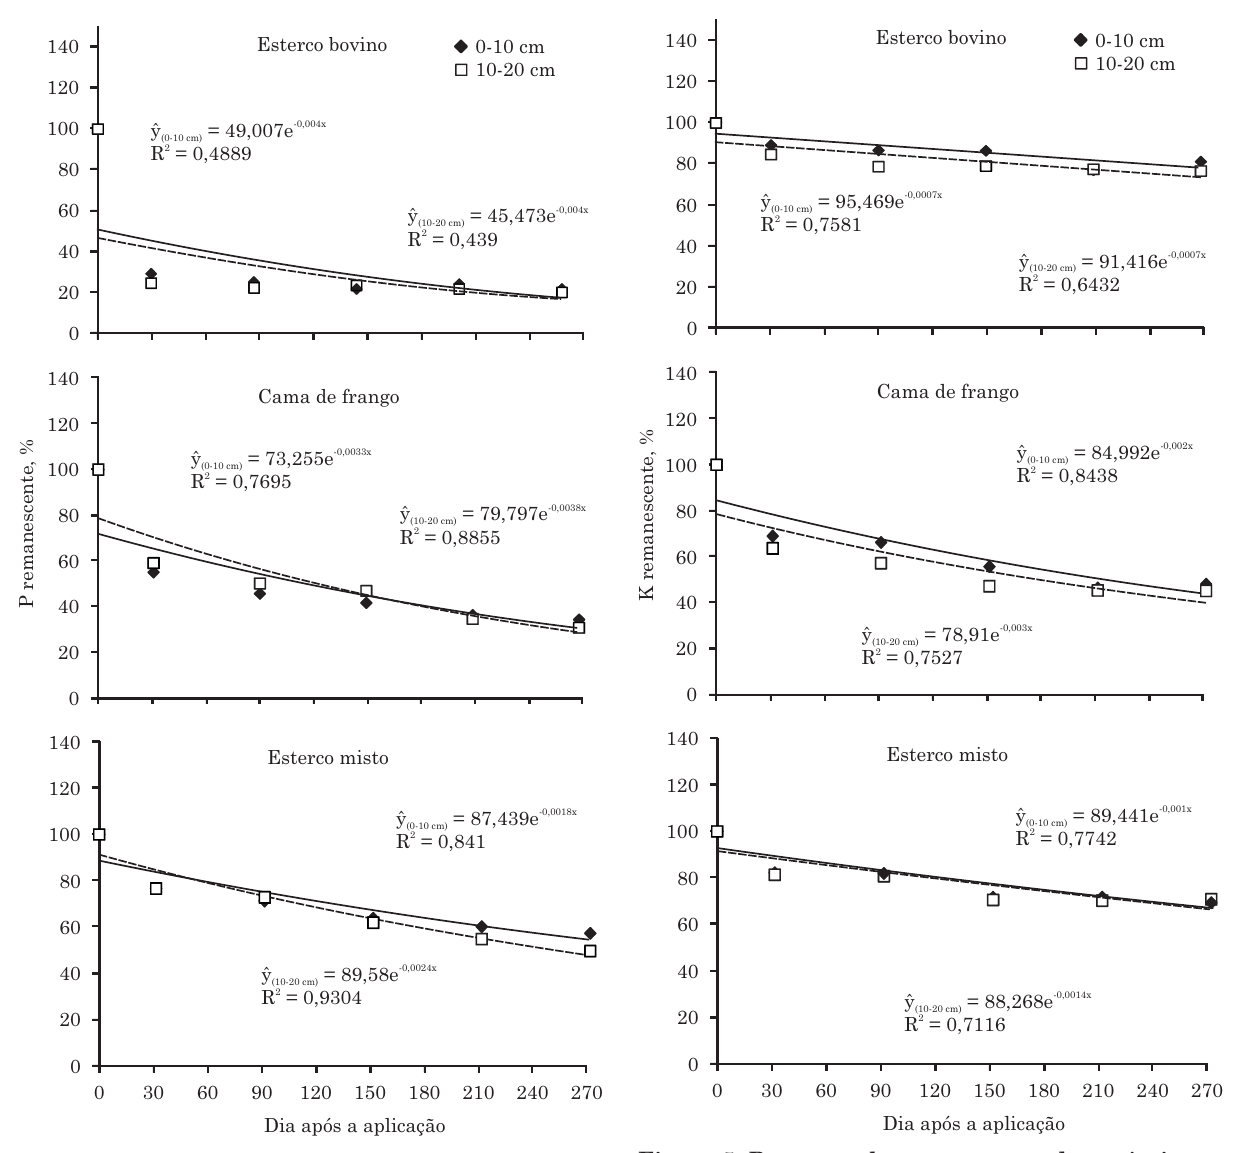
Figura 4. Percentual remanescente de fósforo em amostras de esterco bovino, cama de frango e esterco misto, nas camadas de 0-10 e 10-20 cm, em função dos períodos de avaliação.